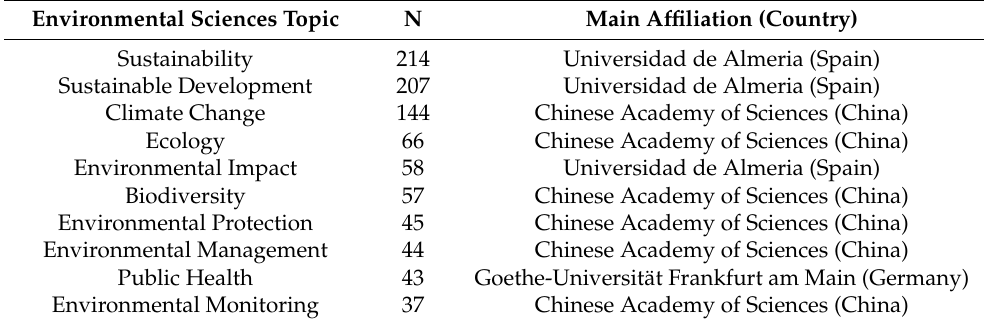
Table 15. Top 10 environmental sciences keywords in bibliometric publications in this category and the main affiliations using